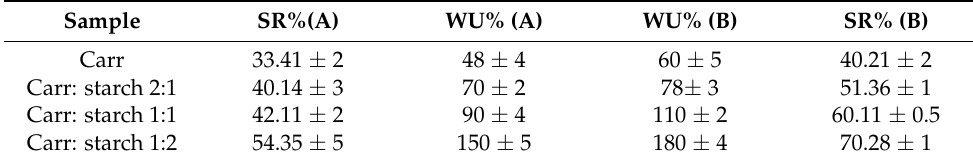
Table 2. Water uptake and swelling ratio values of Carr/starch membranes before (A) and after (B) enzymatic